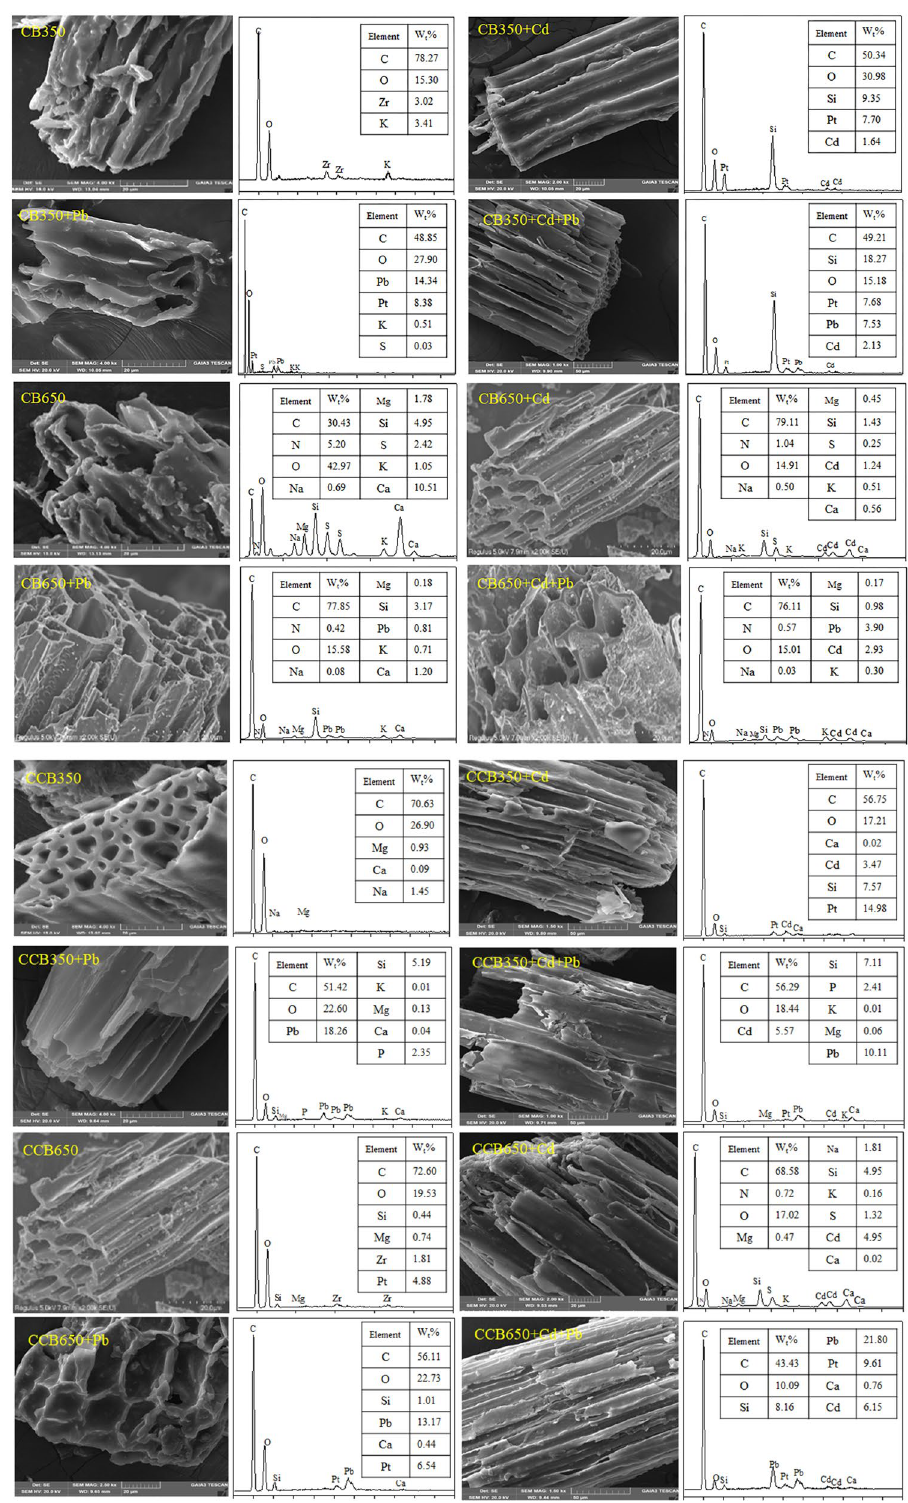
Figure 3. SEM images (left) and corresponding EDS spectra (right) of fresh and aged biochars produced at 350 °C and 650 °C (CB350, CB650, CCB350, and CCB650, respectively) before and after reaction with Cd 2+ and Pb 2+ in the single and binary